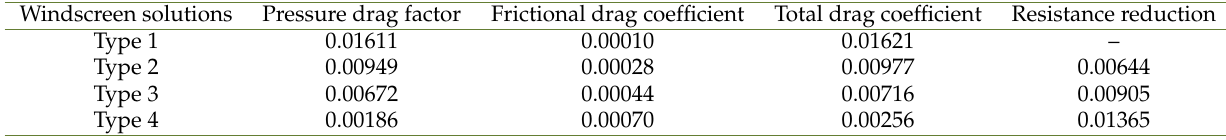
Table 4. Comparison of wind block drag coefficients.